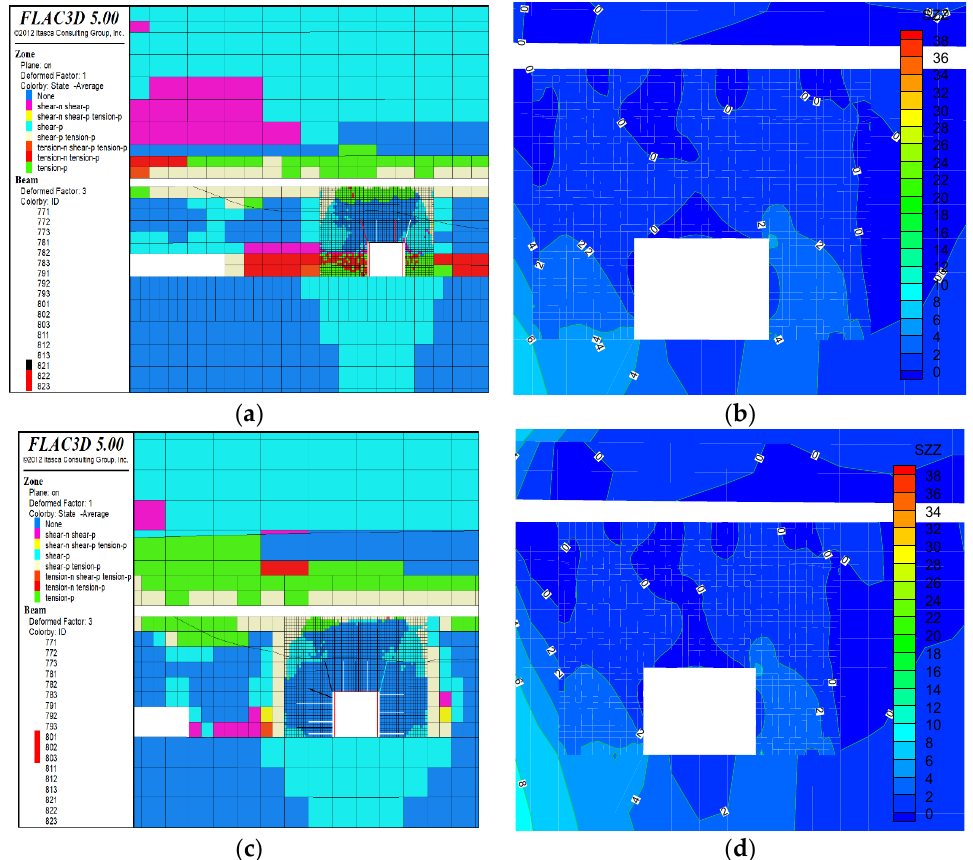
Figure 19. Plastic zone and stress diagram of surrounding rock in two support schemes. ( a ) Plastic zone of original support scheme. ( b ) Vertical stress of original support scheme. ( c ) Plastic zone of proposed support scheme. ( d ) Vertical stress of proposed support scheme.